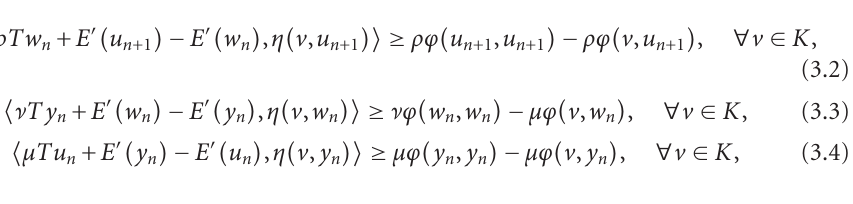
Algorithm 3.2. For a given u 0 ∈ H , compute the approximate solution u n +1 by the iterative schemes